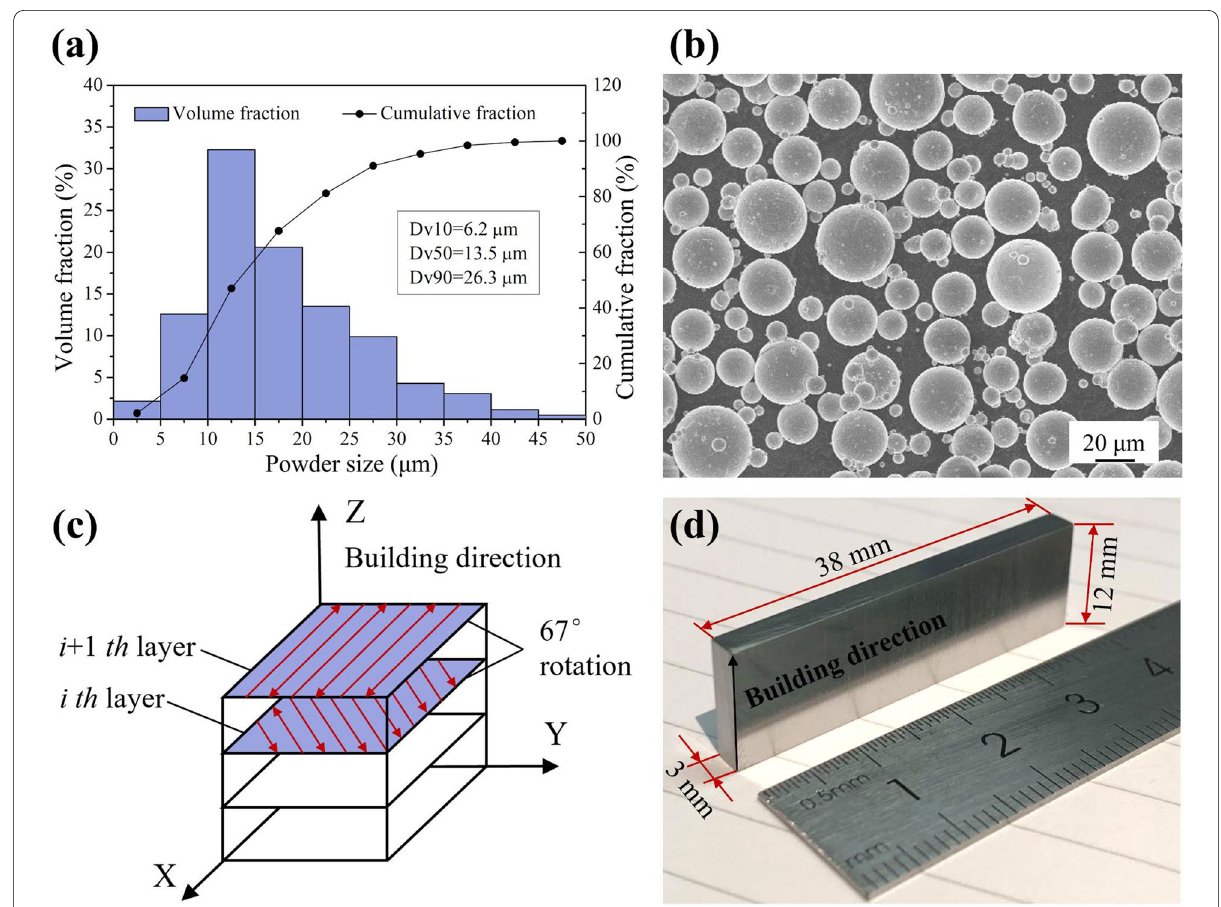
Figure 1 Characteristics of the Ti6Al4V alloy powders and workpiece preparation by SLM: a powder size distribution, b powder morphology, c scanning strategy of SLM, and d a workpiece built by SLM